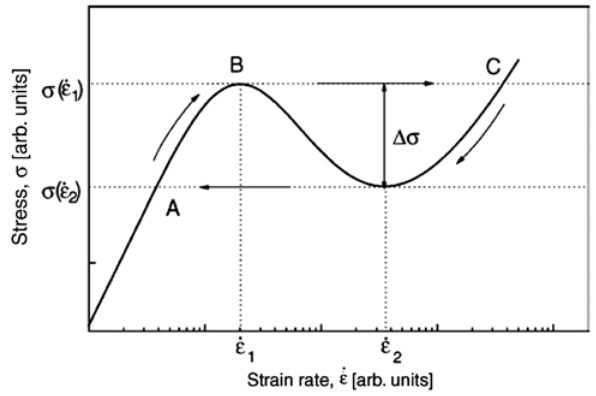
Figure 4: Flow stress dependence of the strain rate for an Al-Mg alloy at room temperature [17].